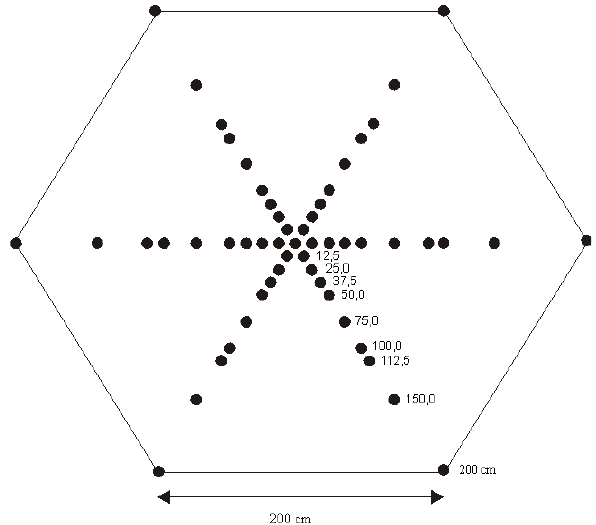
Figura 1. Hexágono de amostragem, com dez amostras simples por semidiagonal, sendo a amostra simples central comum às seis